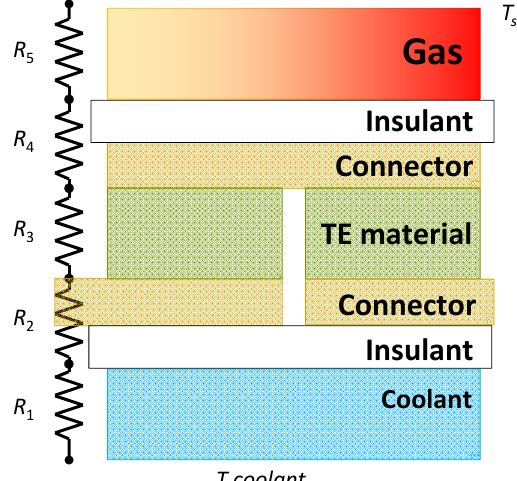
Figure 6. Scheme for the evaluation of the performance of one thermoelectric generator